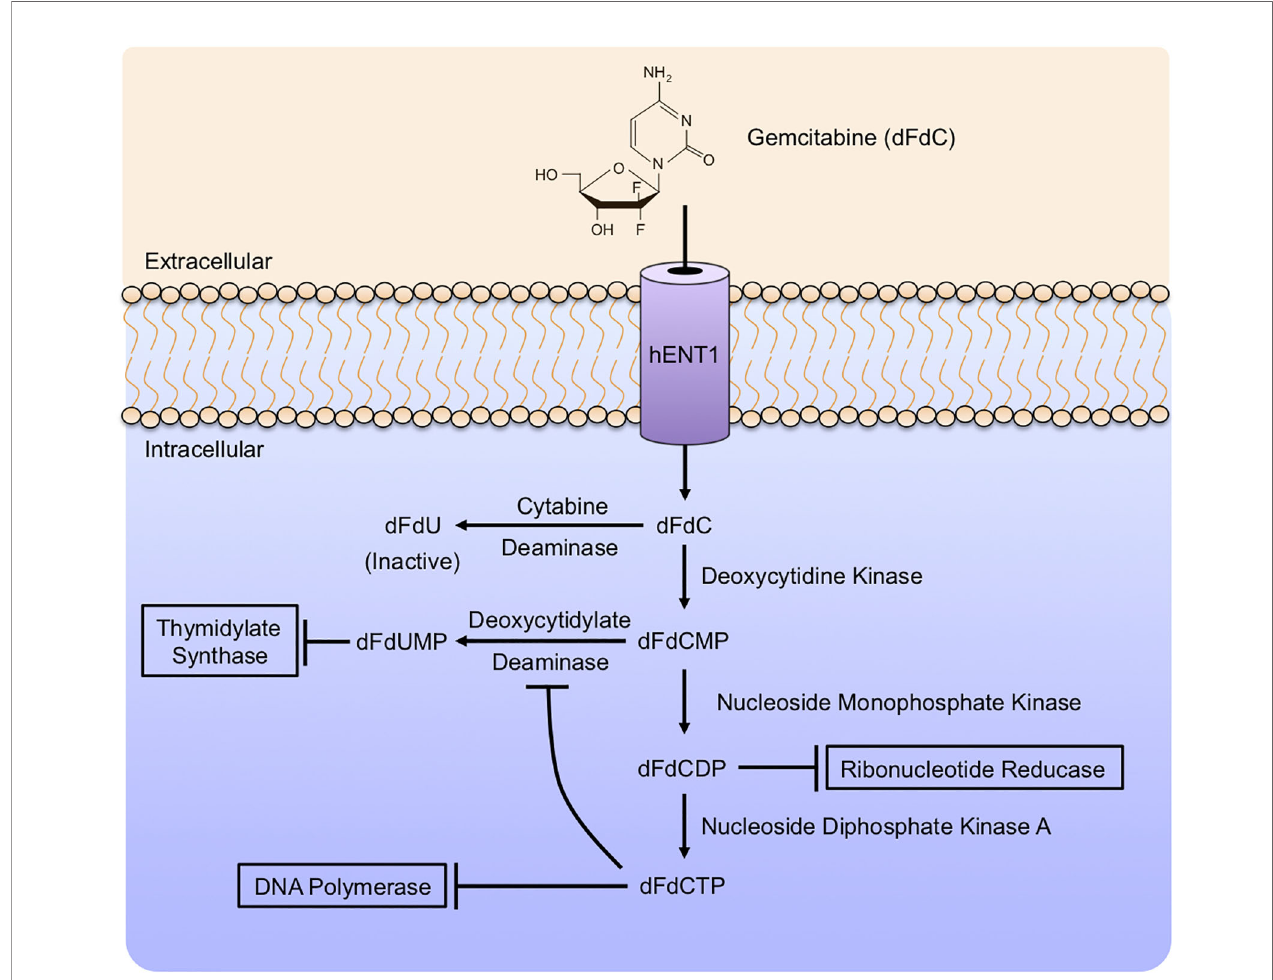
FIGURE 4 | Gemcitabine mechanism of action. Gemcitabine enters cells via several nucleotide transporters, primarily Human Equilibrative Nucleoside Transporter 1 (hENT1). In the cytoplasm, Gemcitabine is modi fi ed extensively by a series of enzymatic reactions. Gemcitabine is phosphorylated by Deoxycytidine Kinase (dCK) to form dFdC monophosphate (dFdCMP), the rate-limiting step in Gemcitabine metabolism. Subsequently, dFdCMP can be deaminated by Deoxycytidylate Deaminase to form dFdUMP, a potent inhibitor of Thymidylate Synthase. Alternatively, dFdCMP can be phosphorylated by Nucleoside Monophosphate Kinase to become dFdC diphosphate (dFdCDP), inhibiting Ribonucleotide Reductase. dFdCDP can be further phosphorylated by Nucleoside Monophosphate Kinase A to form dFdCTP, which inhibits DNA polymerases. As an alternative to these activating modi fi cations, Gemcitabine can be deaminated by Deoxycytidylate Deaminase to form dFdU, an inactive metabolite with no known anti-neoplastic